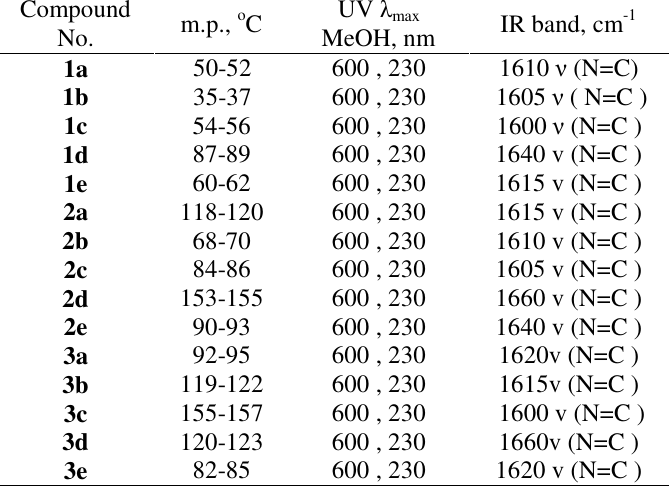
Table 1. Analytical and spectral date of compounds.